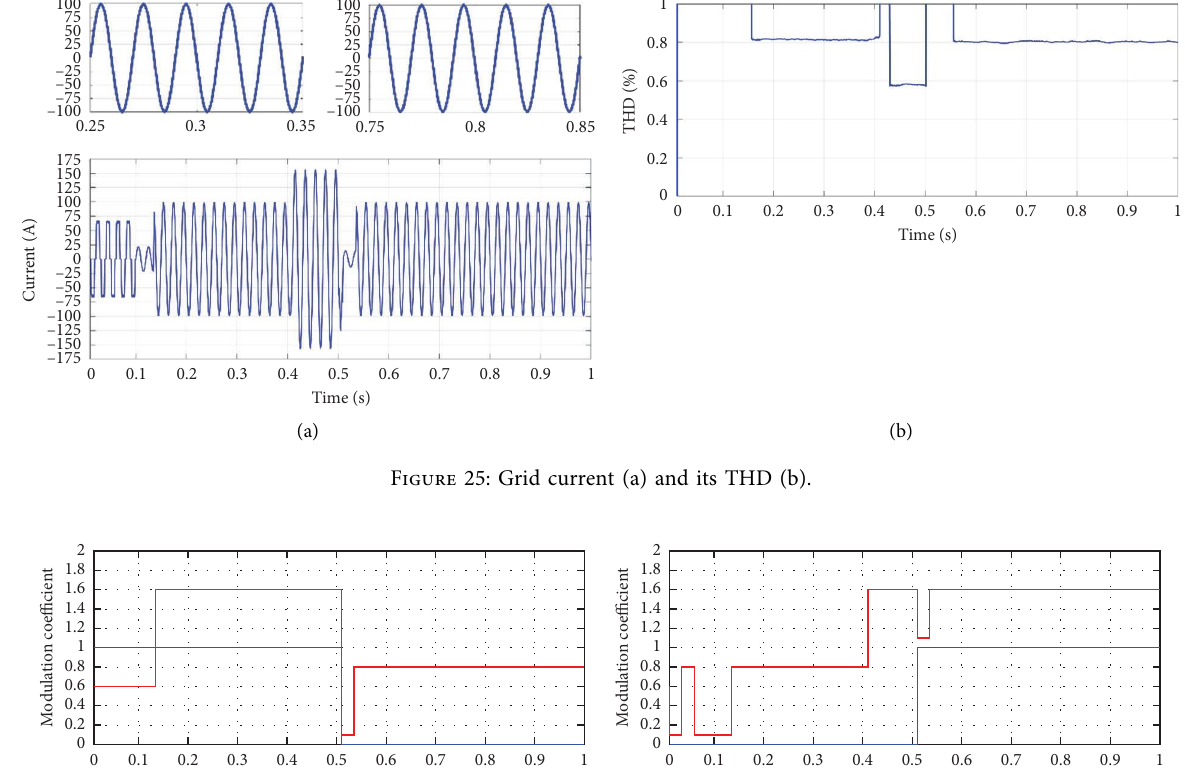
Figure 26: Modulation coefcients of reference currents of the grid-connected inverter of PV system (a) and wind generator (b).